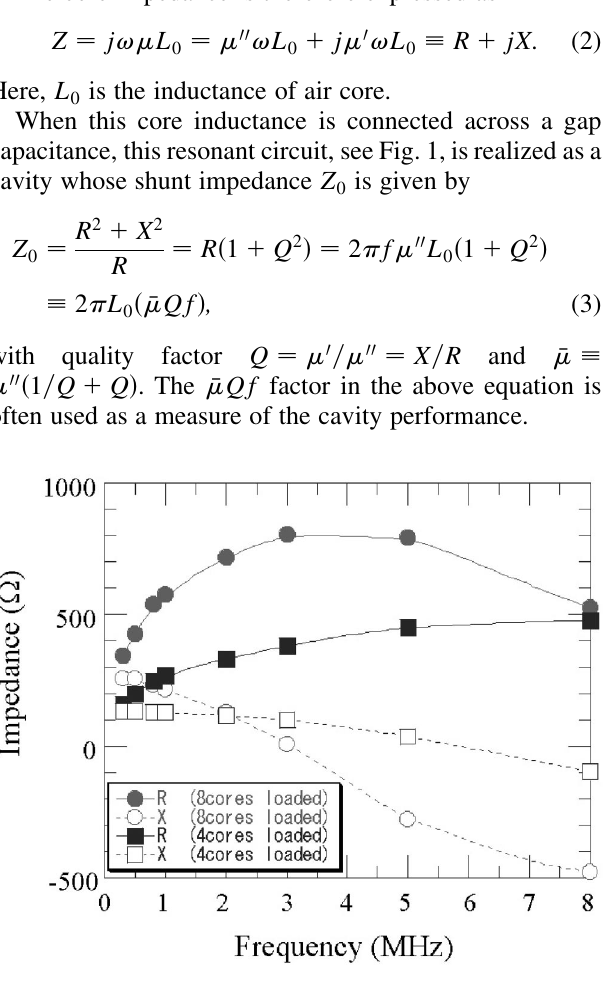
FIG. 2. An example of the cavity impedance loaded with the MA cores. Eight or four FINEMET cores (inner diameter, 290 mm; outer diameter, 650 mm; thickness, 25 mm) are loaded in a cavity with a gap capacitance assumed to be 30 pF. Solid and open marks correspond to real and imaginary parts of the cavity impedance, respectively.